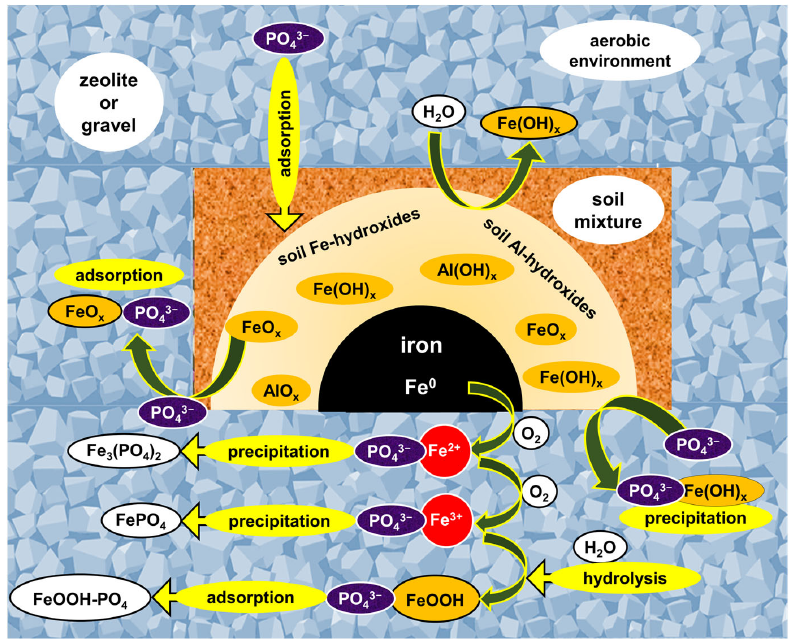
Figure 7. MSL layers design associated with the removal mechanisms of